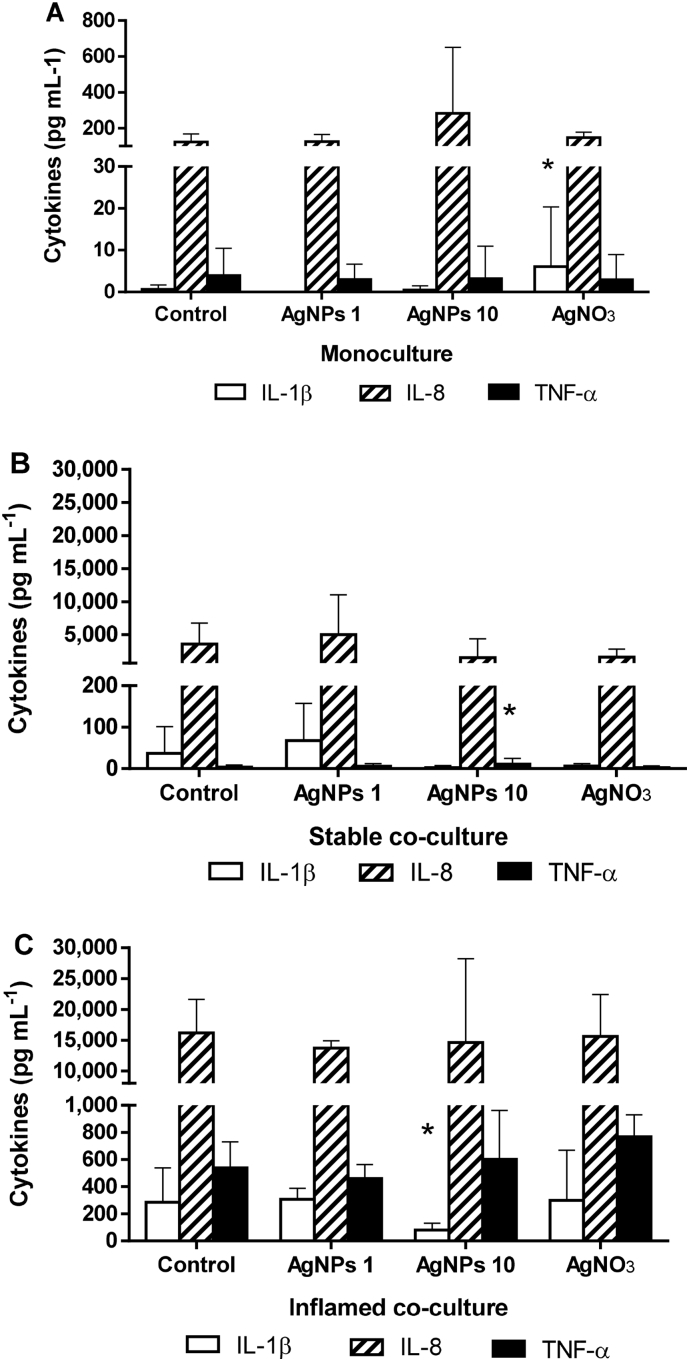
Cytokine release in response to 24 h exposure to AgNPs or AgNO3.